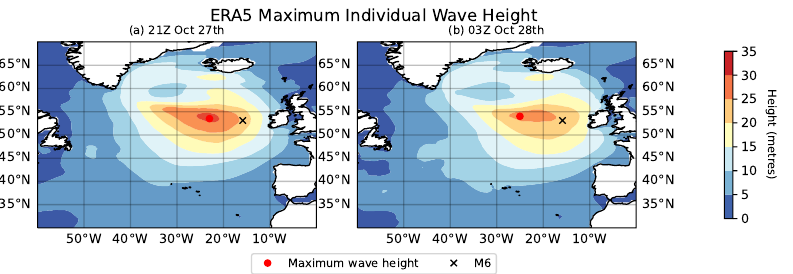
Figure 8. ERA5 maximum individual wave height, H max . The location of maximum wind speeds/wave heights is indicated, along with the M6 location. ( a ) very large wave heights, of similar magnitude to the observed rogue wave, were present in the ERA5 reanalysis. ( b ) the maximum waves estimated by ERA5 near M6 at the time of the rogue wave observation were far smaller.